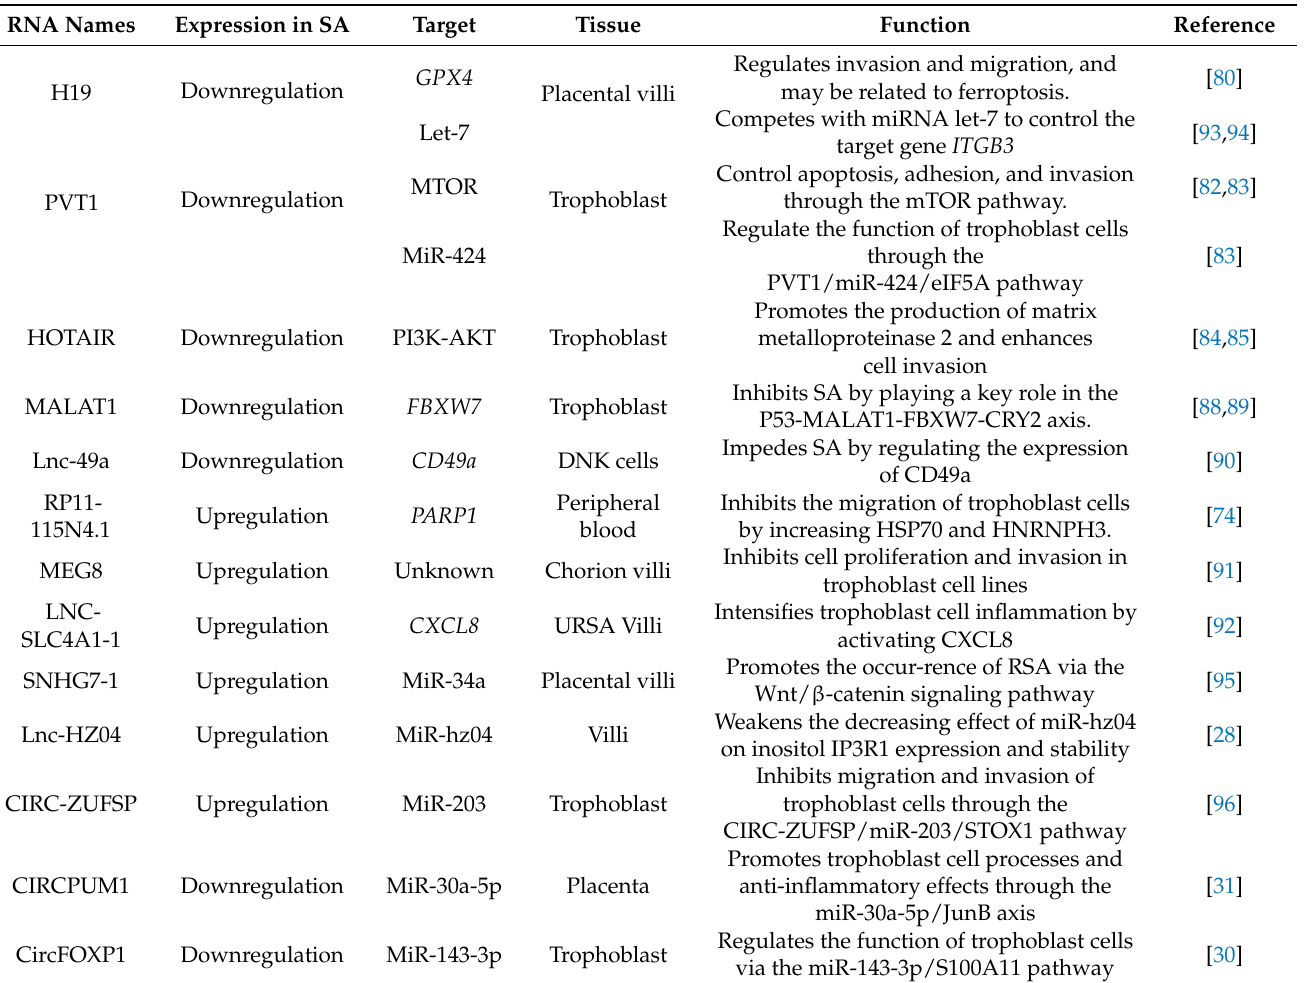
Table 2. lncRNAs and circRNAs involved in the occurrence of